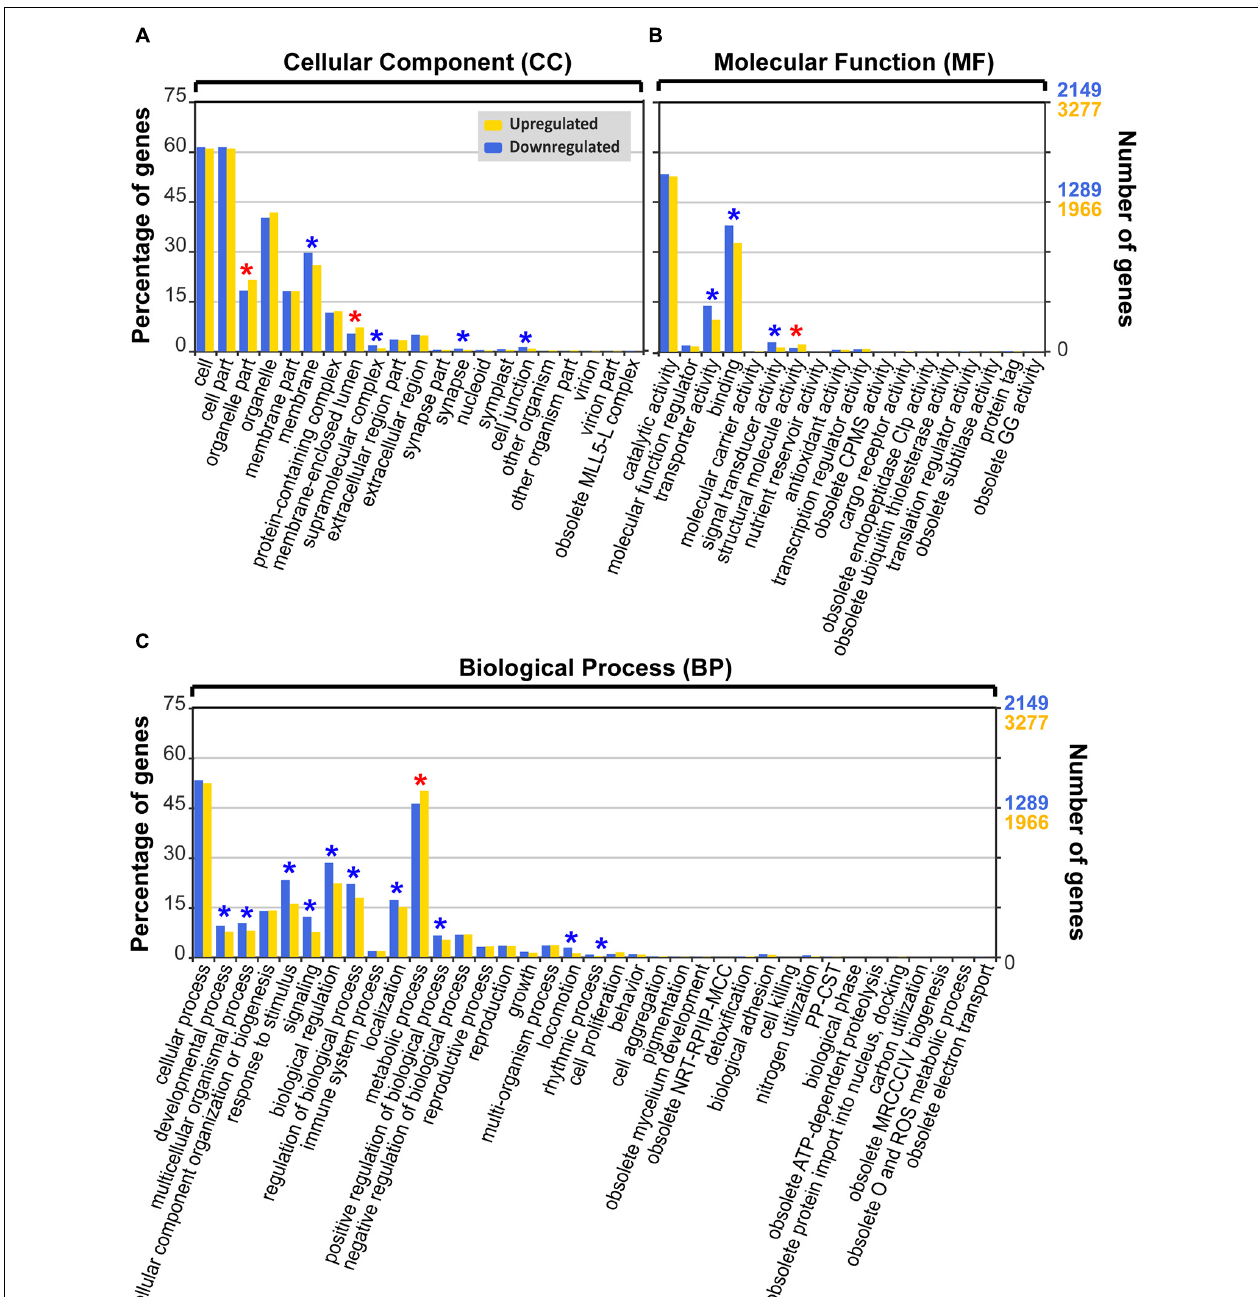
FIGURE 5 | Gene Ontology (GO) functional classification (level 2) of differentially expressed genes (DEGs) of Biecheleriopsis adriatica under cold stress against optimal temperature. Category: (A) cellular component, (B) molecular function, and (C) biological process. The GO subcategories with significantly more upregulated genes than downregulated genes ( p < 0.05, Pearson’s chi-squared test) are marked as red asterisks, whereas the GO subcategories with significantly more downregulated genes than upregulated genes are marked as blue asterisks. CPMS, cyclic pyranopterin monophosphate synthase; GG, gamma-glutamyltransferase; NRT-RPIIP-MCC, negative regulation of transcription from RNA polymerase II promoter during mitotic cell cycle; PP-CST, presynaptic process involved in chemical synaptic transmission; MRCCCIV, mitochondrial respiratory chain complex IV; O, oxygen; ROS, reactive oxygen species.